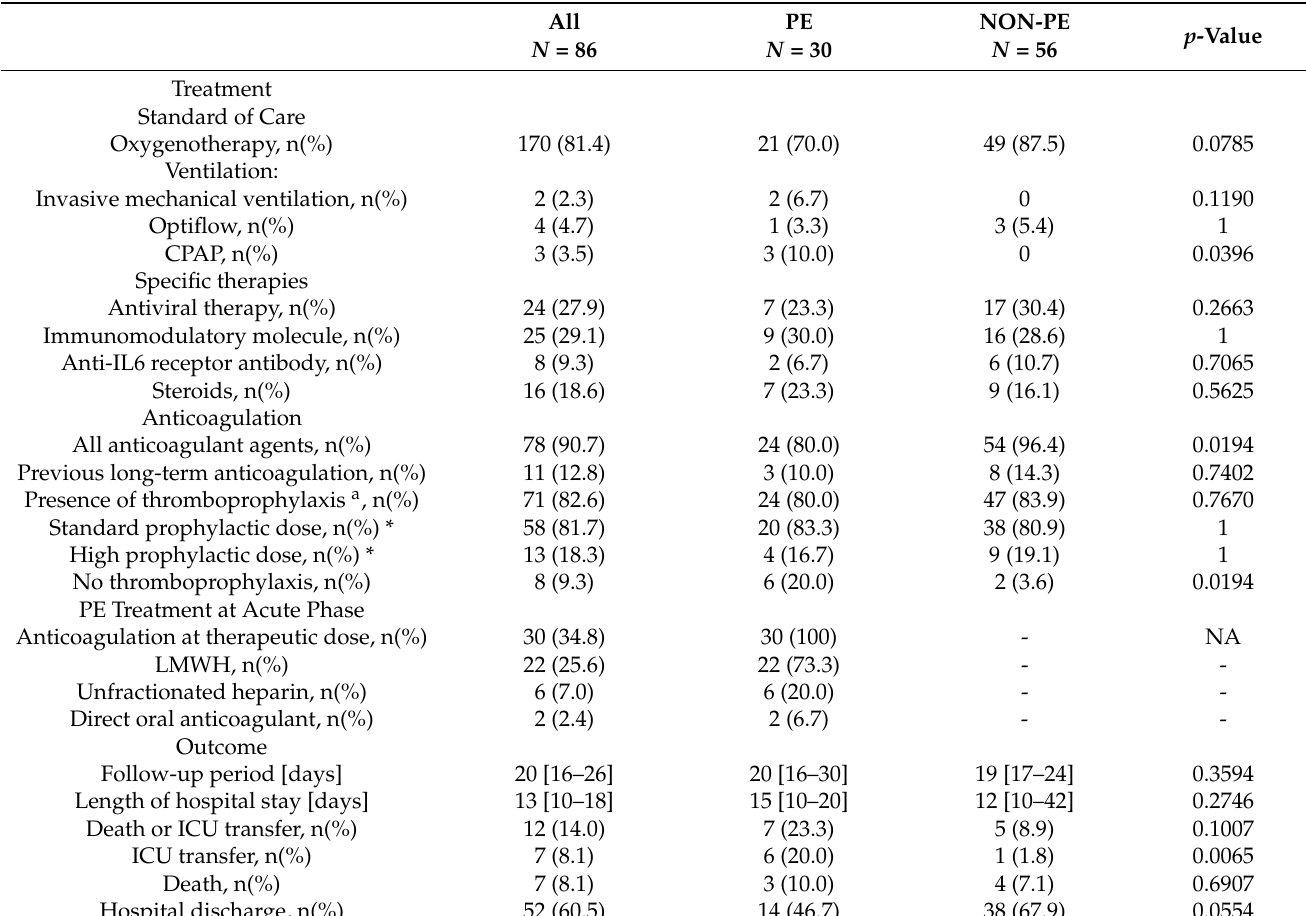
Table 2. Therapeutic Management and